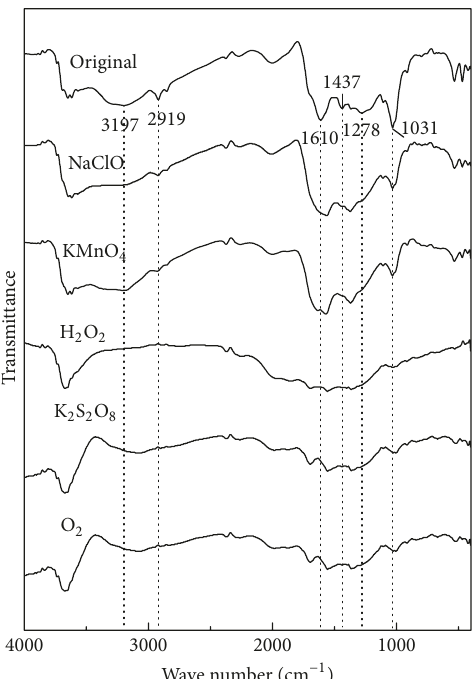
Figure 8: The FTIR spectra of the lignite before and after oxidative